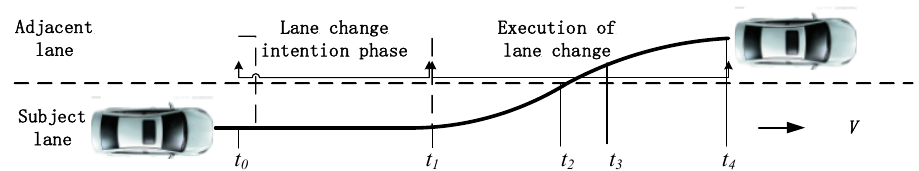
Figure 5. Lane-change process.